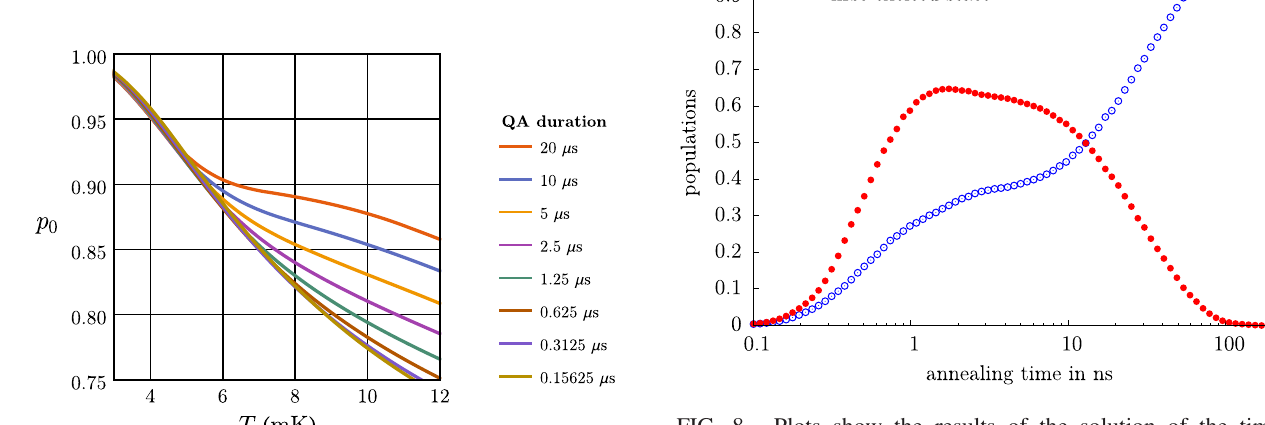
FIG. 8. Plots show the results of the solution of the time- dependent Schrödinger equation for the closed system QA. FIG. 6. Success probability of QA p 0 versus T , given by Probabilities of occupation of ground state and first excited state theoretical modeling [Eq. (A2)]. Different colors correspond as a function of QA time are plotted with blue and red points, to different durations of the QA process T . Plots corre- respectively. The QA time to reach probability of success 0.95 QA spond to h 1 ¼ 0 . 44 . equals 70.9 ns. All plots correspond to h 1 ¼ 0 . 44